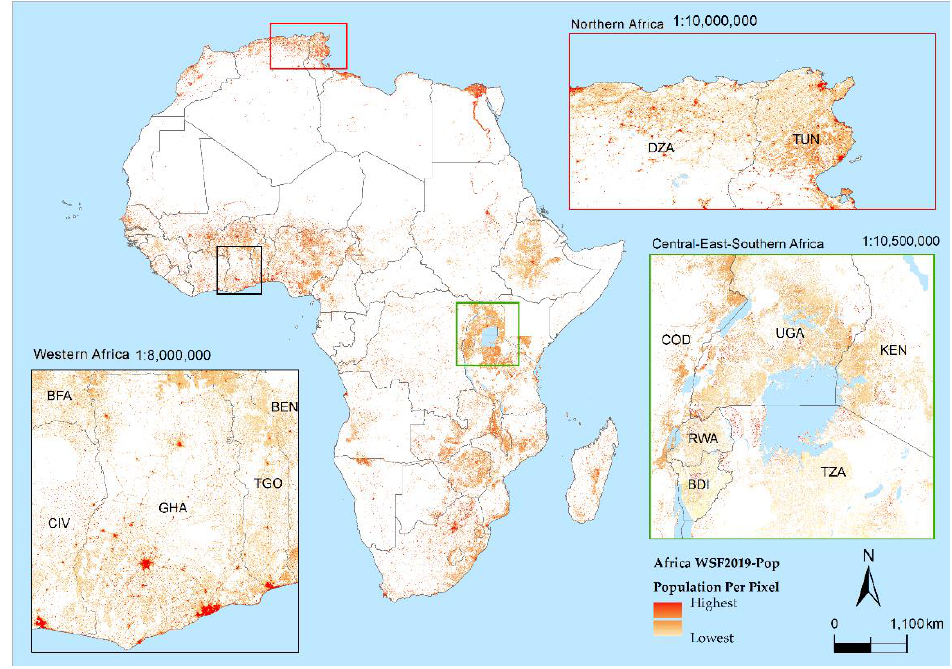
Figure 3. World Settlement Footprint 2019 Population dataset for Africa (WSF2019-Pop). Colour ranges and values are country specific and represent the estimated population per every ~10m pixel.